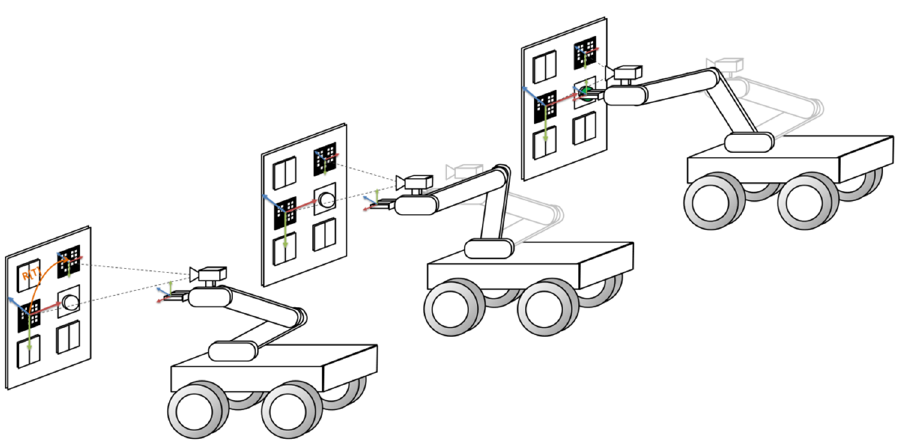
Figure 4. The manipulator adjusts its gripper coordinate system to the panel’s global coordinate system located in one of the recognized markers. Algorithm 1. Marker detection algorithm.